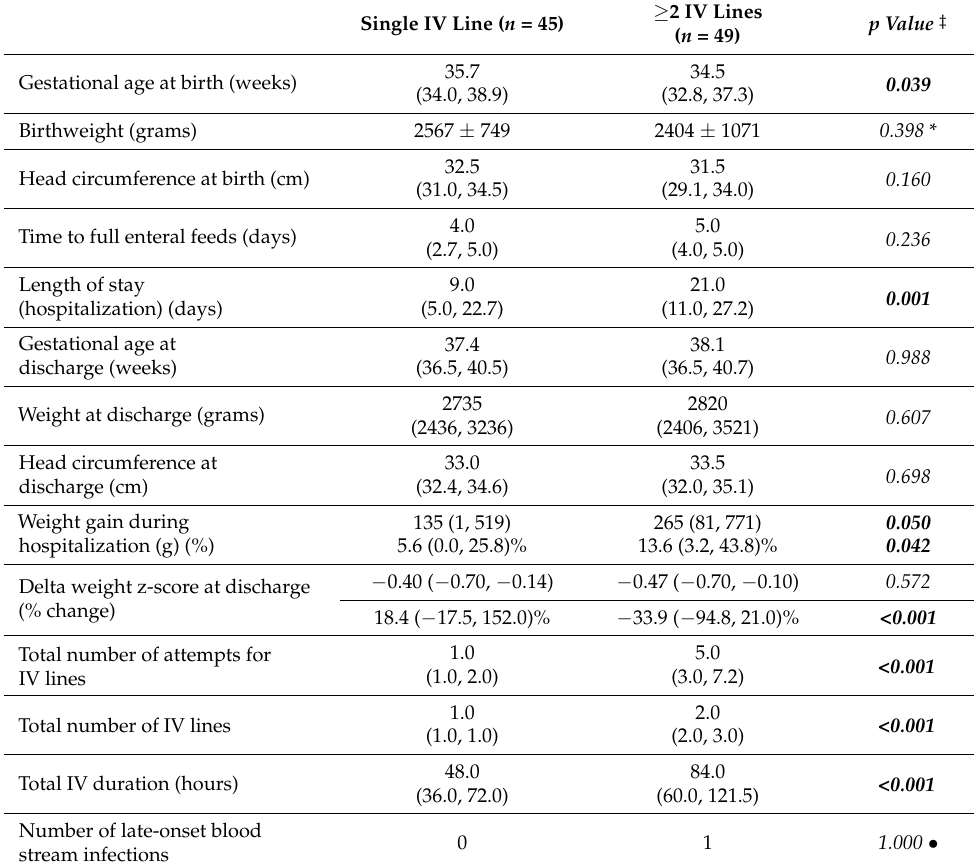
Table 5. Analysis of clinical characteristics and outcomes by patients, only for those that had IV lines. In this analysis, we compared those who required one IV line vs. those who required two or more IV lines during their NICU course ( n =